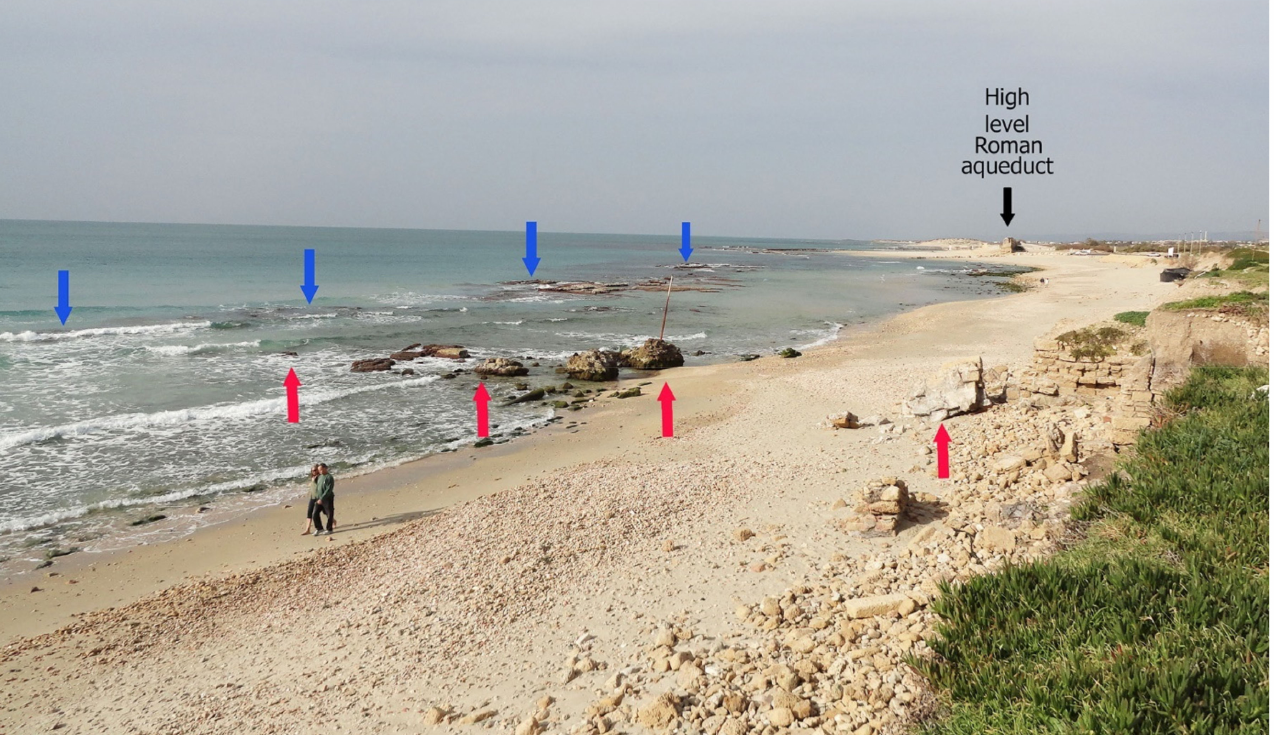
Figure 9. Byzantine sewer outlet on the coast and partly submerged in the northern anchorage (marked with red arrows, for location see Figure 6c), and a beachrock ridge designating the location of the coastline before the construction of the harbor (marked with blue arrows, for location see Figure 6f), looking north.